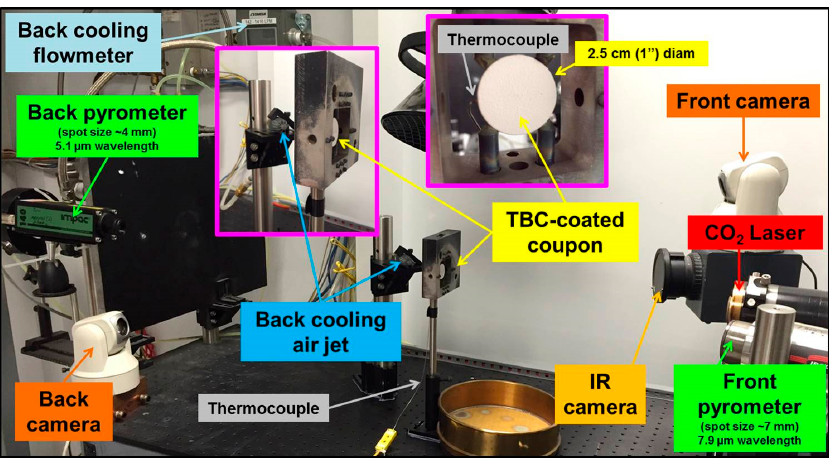
Figure 5. Schematic image of the NRC’s thermal gradient laser-rig.